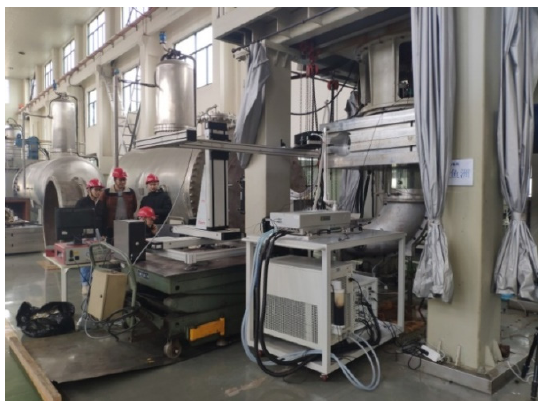
Figure 4. Shooting trigger device: ( a ) optocoupler phase lock trigger; ( b ) optocoupler; ( c ) trigger controller.